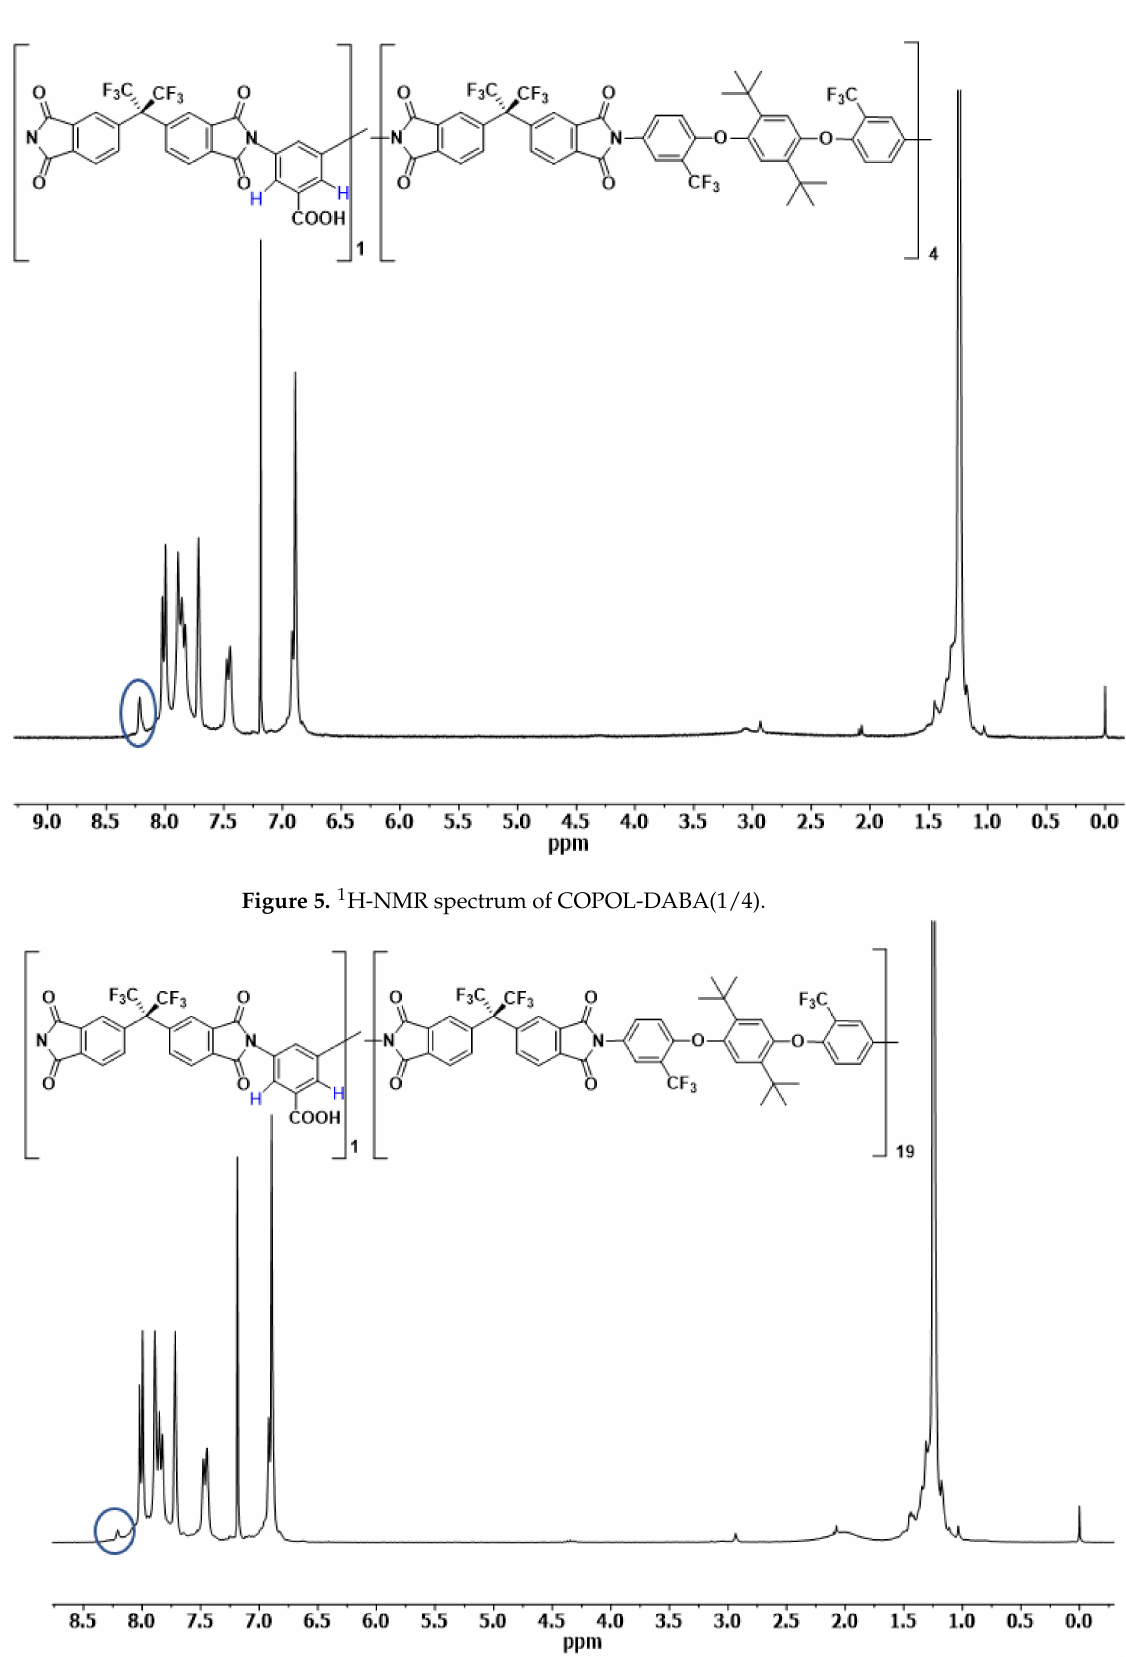
Figure 6. 1 H-NMR spectrum of